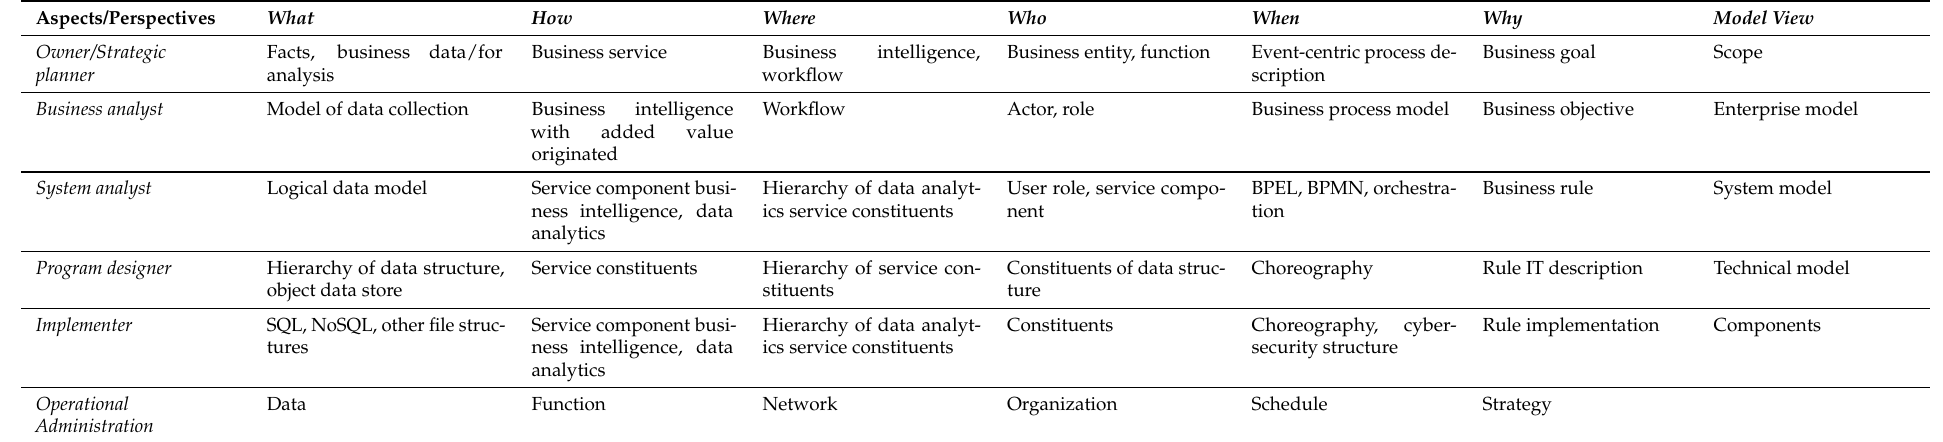
Table 3. An enterprise architecture for a FinTech company based on the Zachman architecture